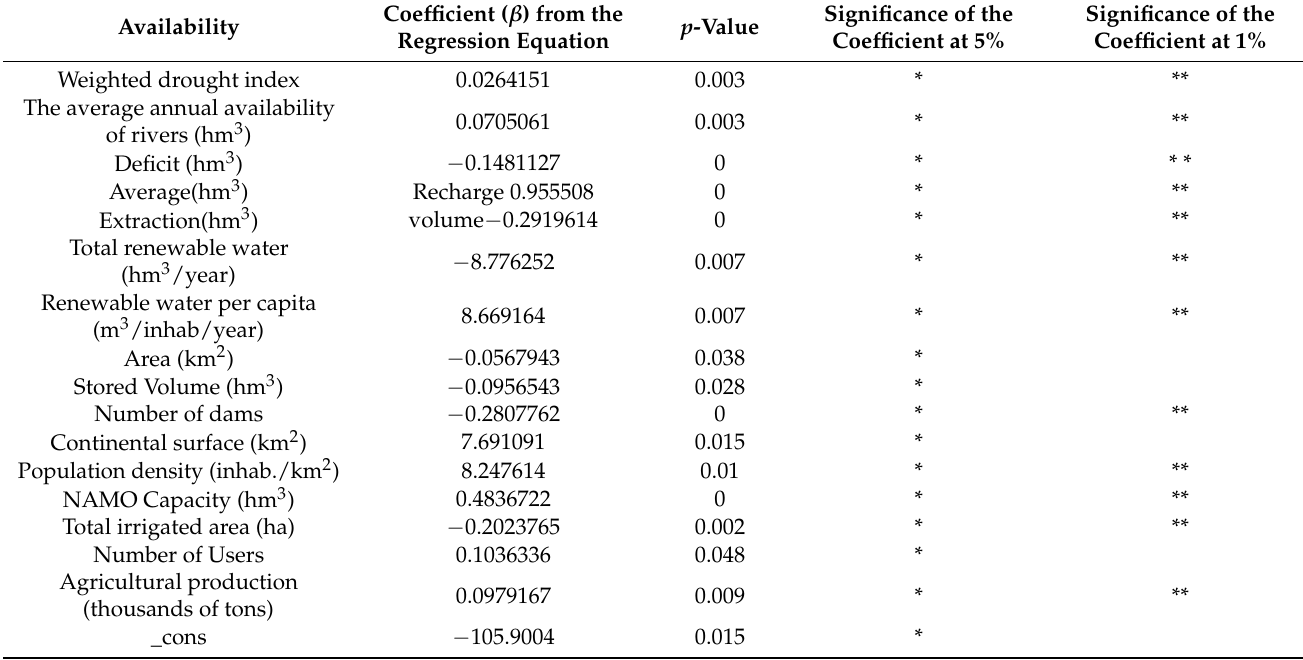
Table 6. Coefficients and their statistical significance values ( p -value, significant at 5% and 1%) referring to model F from the backward perspective.